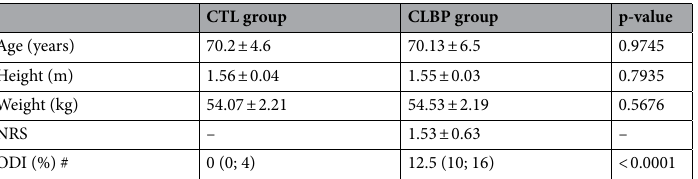
Table 1. Sample characteristics. Data expressed as mean ± SD if presented with a normal distribution, or median and percentiles if presented with nonparametric distribution. The level of significance was 0.05. NRS numeric pain rating scale, ODI Oswestry disability index.